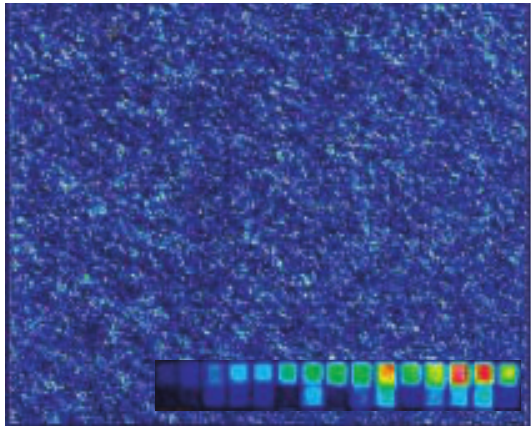
Example of a hybridised GeneChip ® with enlarged probe set of a gene as an insert bottom right. With this chip, 12’626 genes and expressed sequence tags can be assayed in a single experiment. Messenger RNA is copied into labelled cRNA with reverse transcriptase so that the relative abun- dance of individual mRNAs is reflected in the cRNA product. Thus, the intensity of the hybridisation signal for a given gene product is a result of its relative abundance in the tar- get sample. This method has proven to provide excellent specificity and reproducibility. Messenger RNA species comprising 1:10’000–100’000 of the mass of the target poly(A)+RNA, which corresponds to approximately 1 tran- script per 100’000, can readily be detected. The intensity of the hybridisation signal (red = high intensity, dark blue = no signal) for a given gene is a result of its relative abundance in the RNA-derived DNA